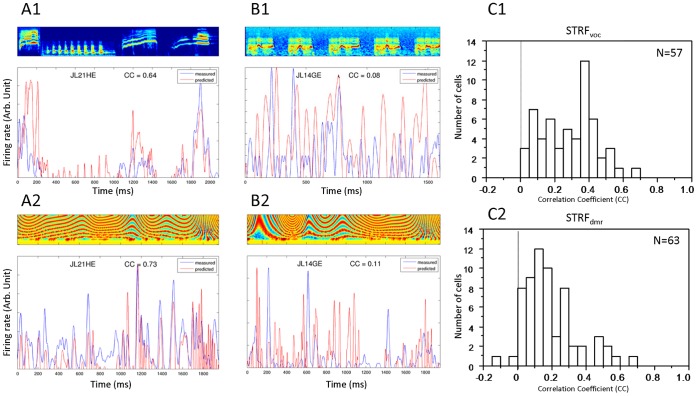
Predictions between measured responses and predicted responses based on the STRFvoc (top, A and C) and on the STRFdmr (bottom, B and D) quantified by the Correlation Coefficients (CC).A–B. Individual examples showing the actual measured responses for a neuron presenting good predictions (JL21HE; left panel) and a neuron presenting poor predictions (JL14GE, middle panel). The top row shows the responses to vocalizations corresponding to spectrograms displayed on the top with the measured responses in blue and the predicted responses in red. The bottom row shows the responses to DMR corresponding to spectrograms displayed on the top (blue curve, measured responses; red curve, predicted responses). C1–C2. Distributions of the CC values for the STRFvoc (A) and for the STRFdmr (B). The mean value of 0.29 obtained for the STRFvoc is significantly higher than the mean value obtained for the STRFdmr (0.19). The CC values presented here are for STRFvoc tested on vocalization responses and for STRFdmr tested on DMR responses.